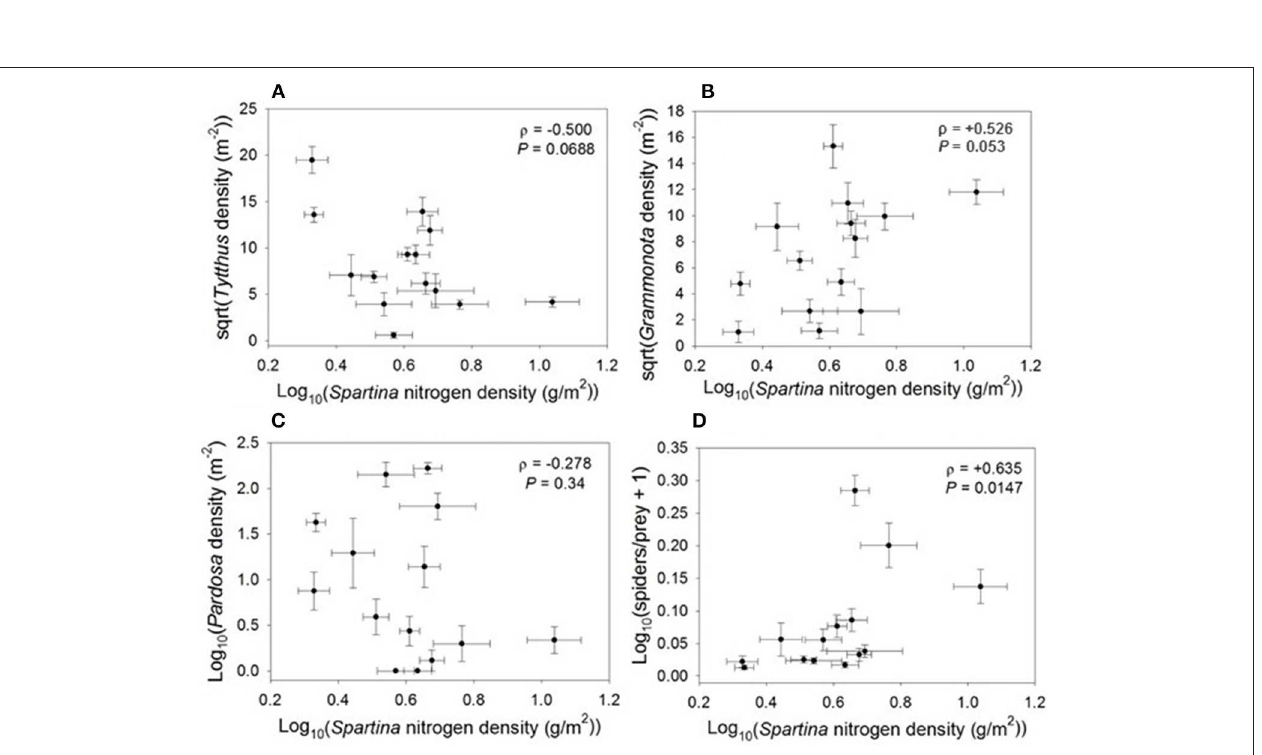
Frontiers in Ecology and Evolution |